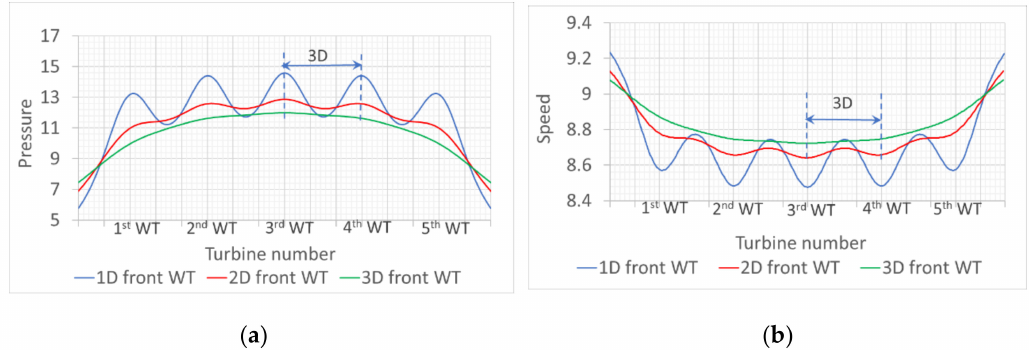
Figure 13. Induction zone of wind turbine row: ( a ) static pressure; ( b )